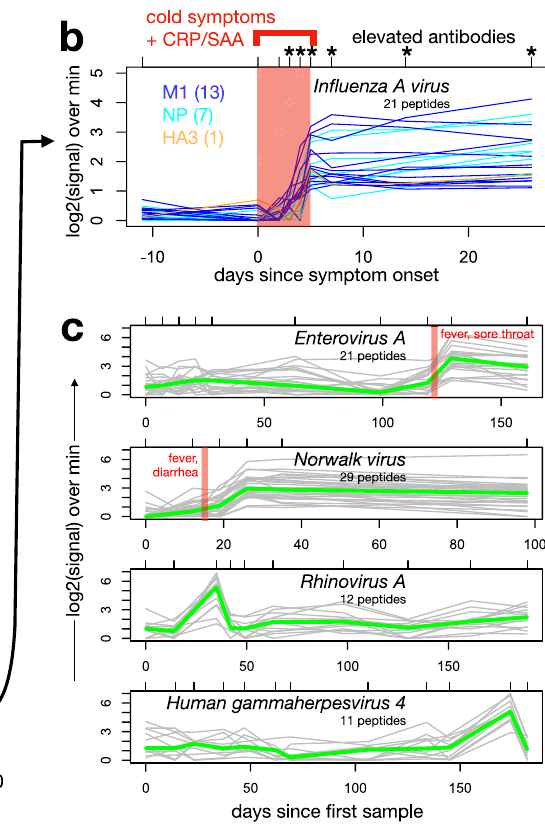
Fig.5|Correlateddynamicsofin fl ammatoryproteins,symptomsandanti-viral antibodiesmeasuredinlongitudinaldriedbloodspotsampleseries.a 379serial dried blood spot samples collected from a participant over a ~7 year span were evaluated for abundance of 4 in fl ammatory proteins — C-reactive protein (CRP), Serum Amyloid A (SAA), Myeloperoxidase (MPO), and total Immunoglobulin M (IgM) — using the SISCAPA assay (upper four panels). Cases where measurements exceeded a threshold (dashed red horizontal lines) at ≥ 2 consecutive timepoints are highlighted (red dots). A subset of 23 samples across the timespan were also evaluated for anti-viral antibody abundance using PepSeq (lower four panels) in whichPSEAdetectedfour signi fi cant VAEs (asterisksand verticalshading).The red ‡ indicates the timing of an antibiotic-responsive pneumonia. For each VAE, med- ians of the leading-edge peptide Z-scores are plotted across all 23 timepoints. Horizontal lines show the median Z-scores of leading-edge peptides at the time- point immediately prior to the corresponding VAE, and the overlaid asterisks indicate subsequent timepoints whose leading-edge peptide signals are